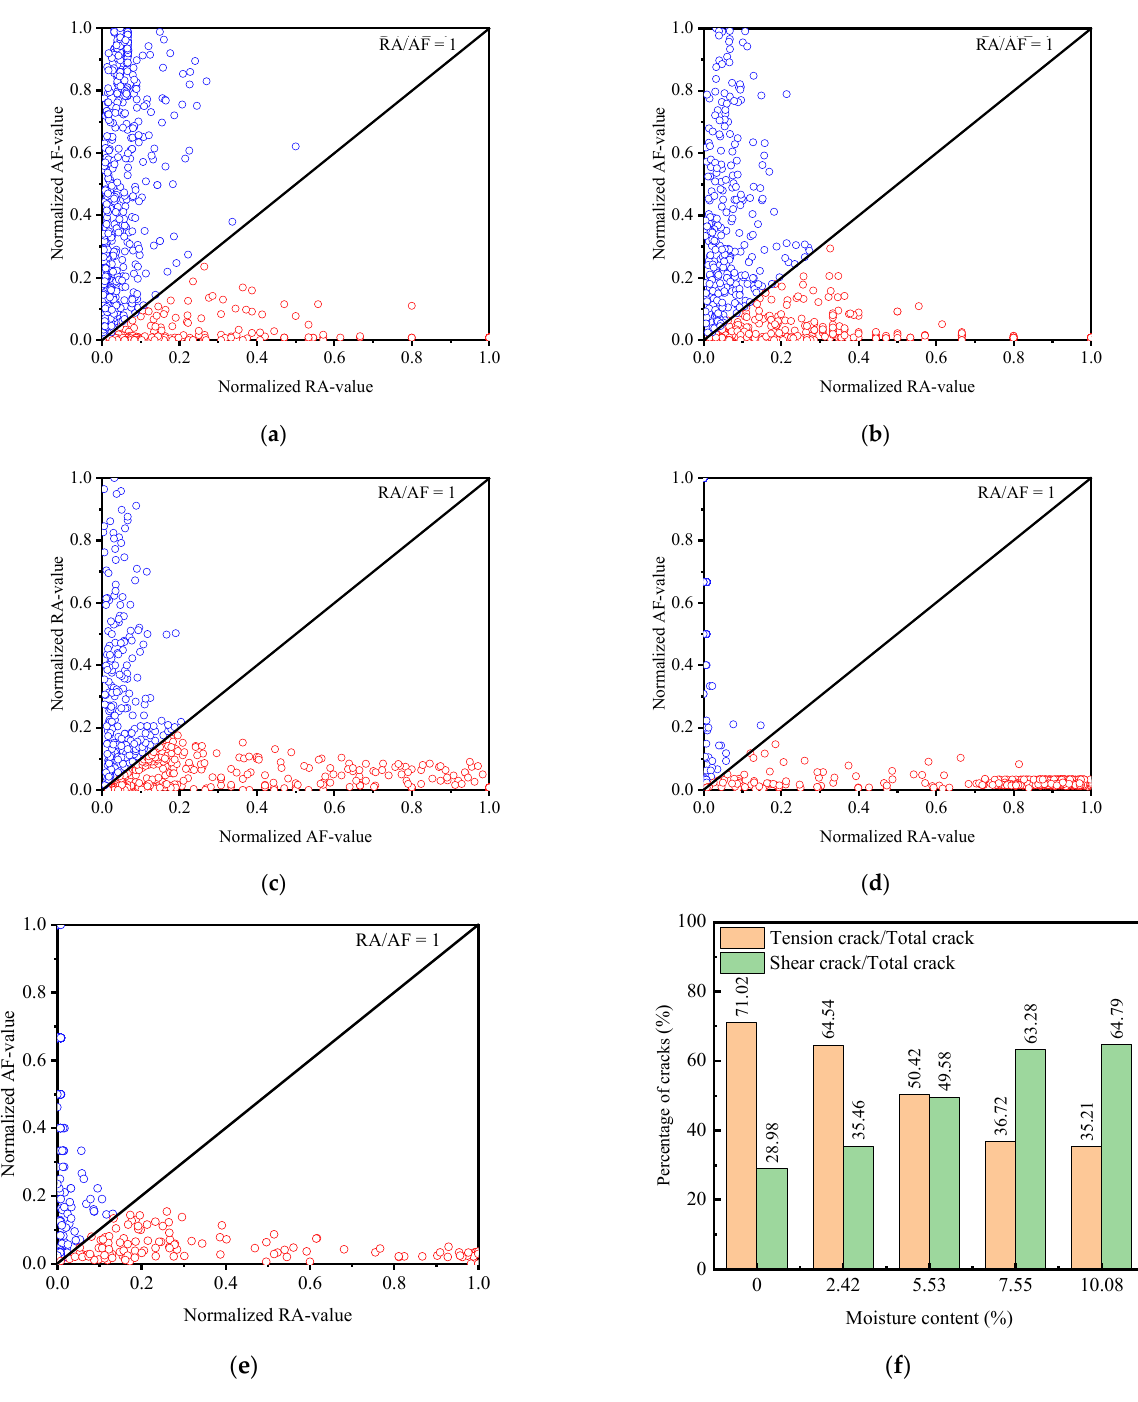
Figure 11. Evolution of tension–shear cracks in coal specimens at different inclination angles ( θ = 0 ◦ ).